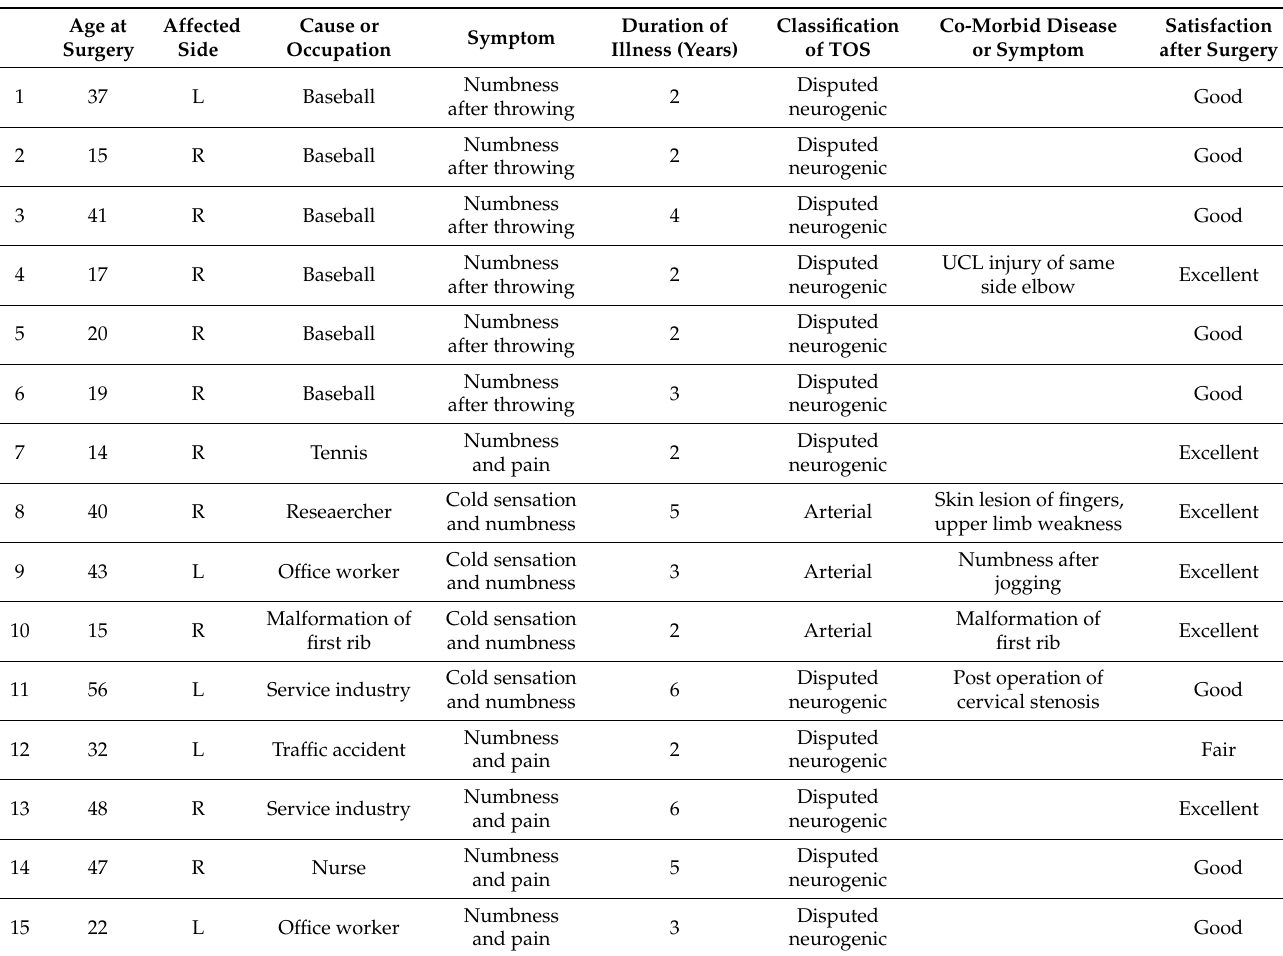
Table 1. Background of patients in the surgery